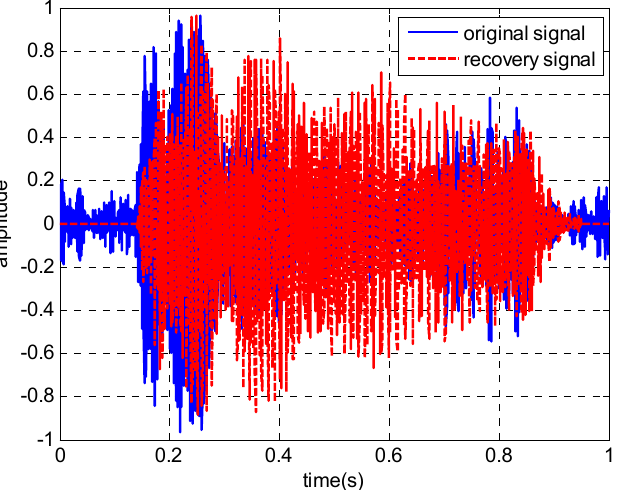
Figure 3. Extracted results of the first four modes, including the mode signal in the TF domain and the time domain, and ( a – d ) are results of the 1st to 4th mode, respectively.